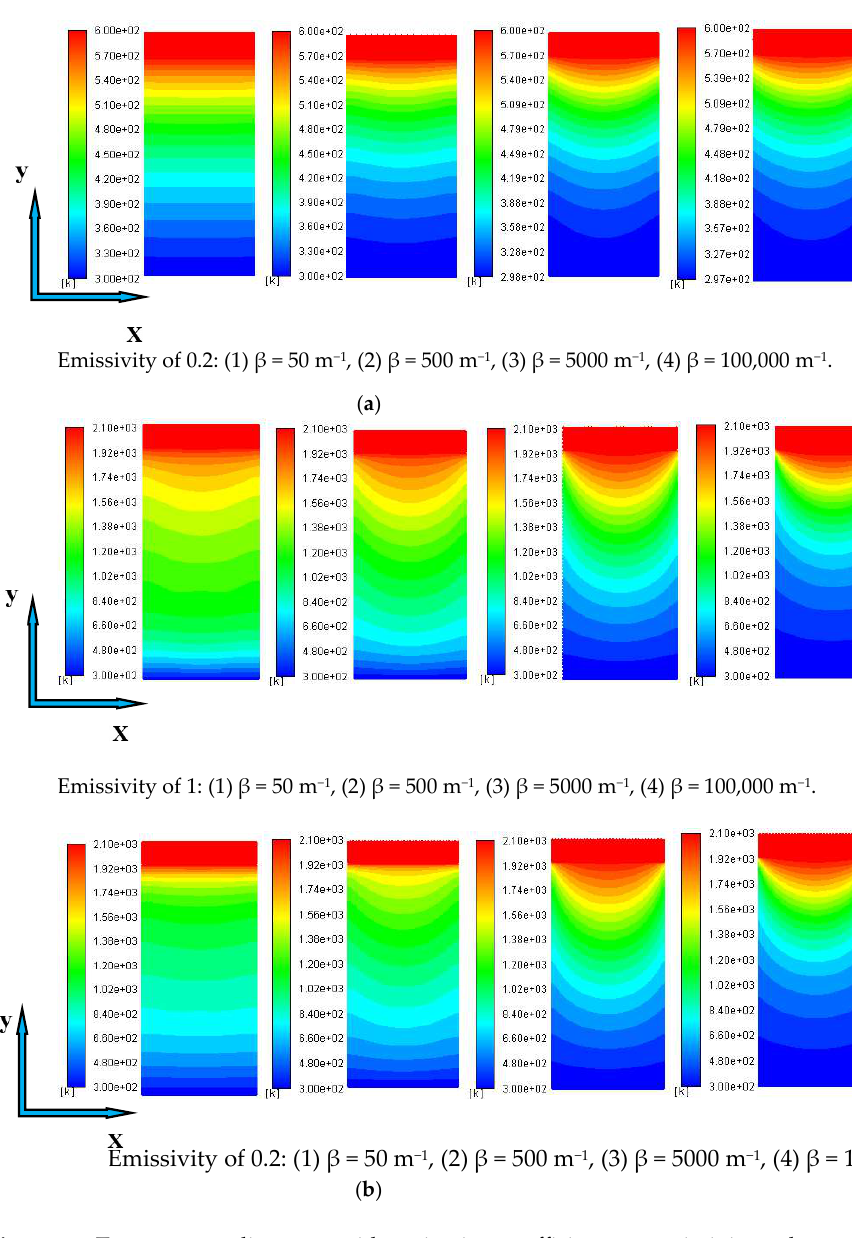
Figure 3. Temperature diagrams with extinction coefficients at emissivity values of 1 and 0.2: ( a ) T = 600 K, ( b ) T = 2100 K.